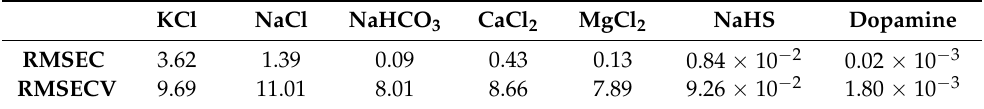
Table 5. Partial least squares regression: root mean square error in calibration (RMSEC) and root mean square error in cross-validation (RMSECV) expressed as mM concentration. KCl NaCl NaHCO 3 CaCl 2 MgCl 2 NaHS Dopamine RMSEC 3.62 1.39 0.09 0.43 0.13 0.84 × 10 − 2 0.02 × 10 − 3 RMSECV 9.69 11.01 8.01 8.66 7.89 9.26 × 10 − 2 1.80 × 10 −